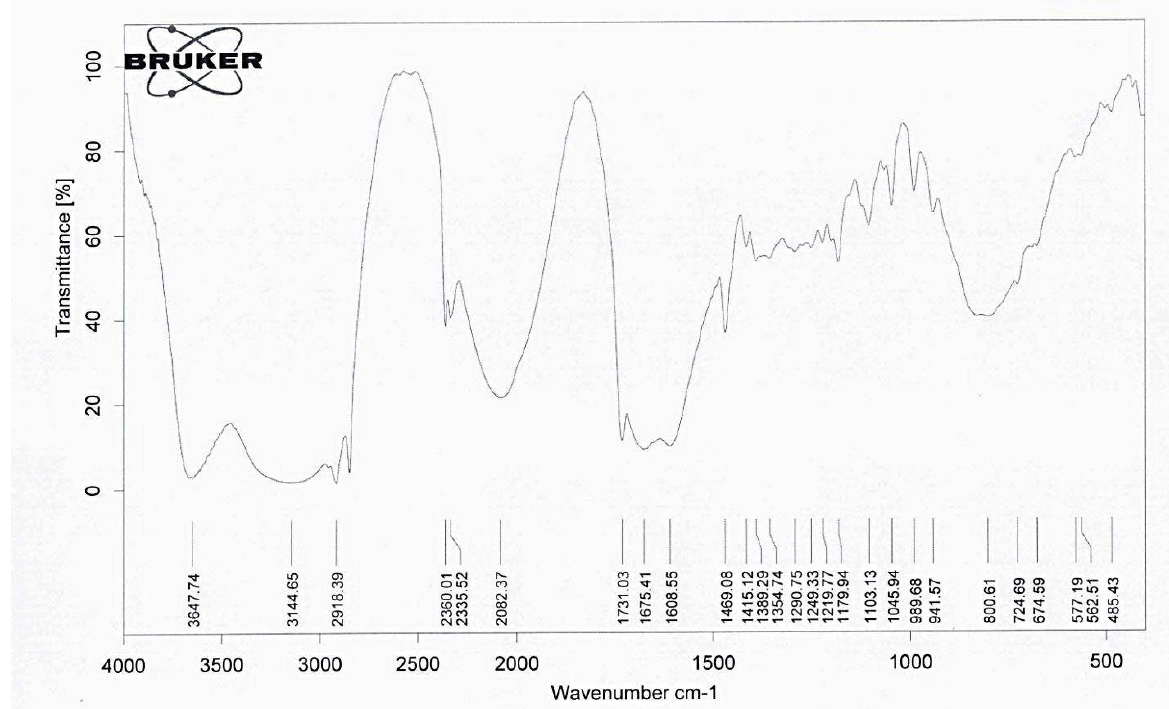
Figure 9 . IR spectrum of darifenacin hydrobromide loaded NLCs ( F 16 ).